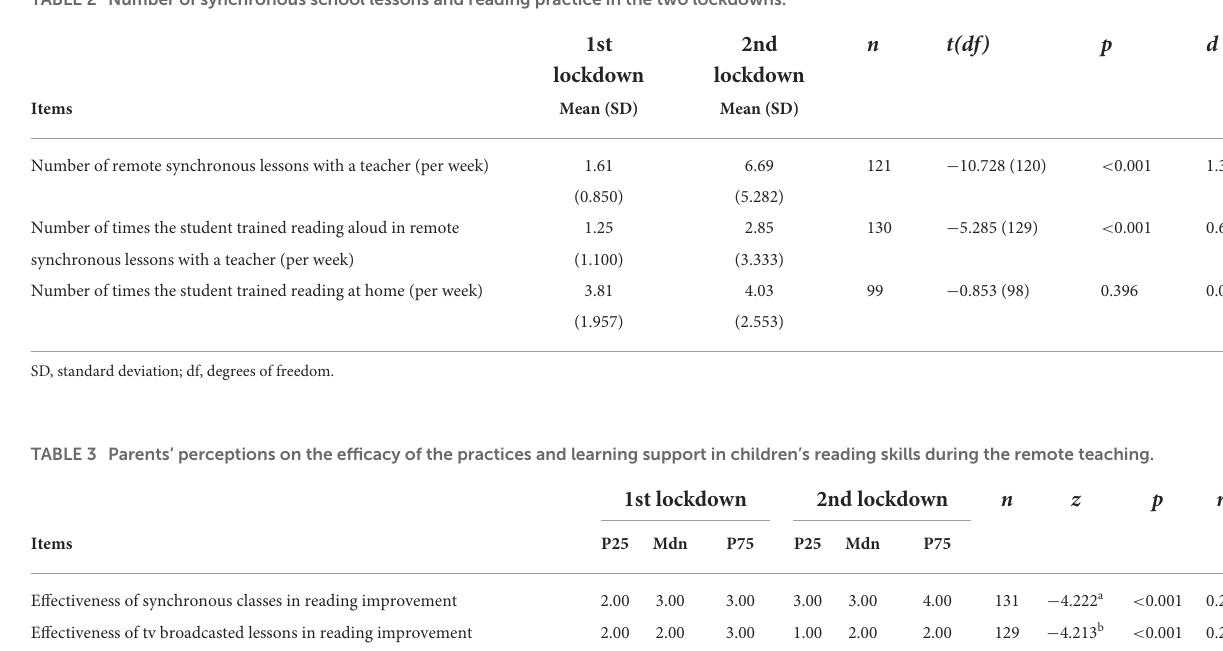
TABLE 2 Number of synchronous school lessons and reading practice in the two lockdowns.